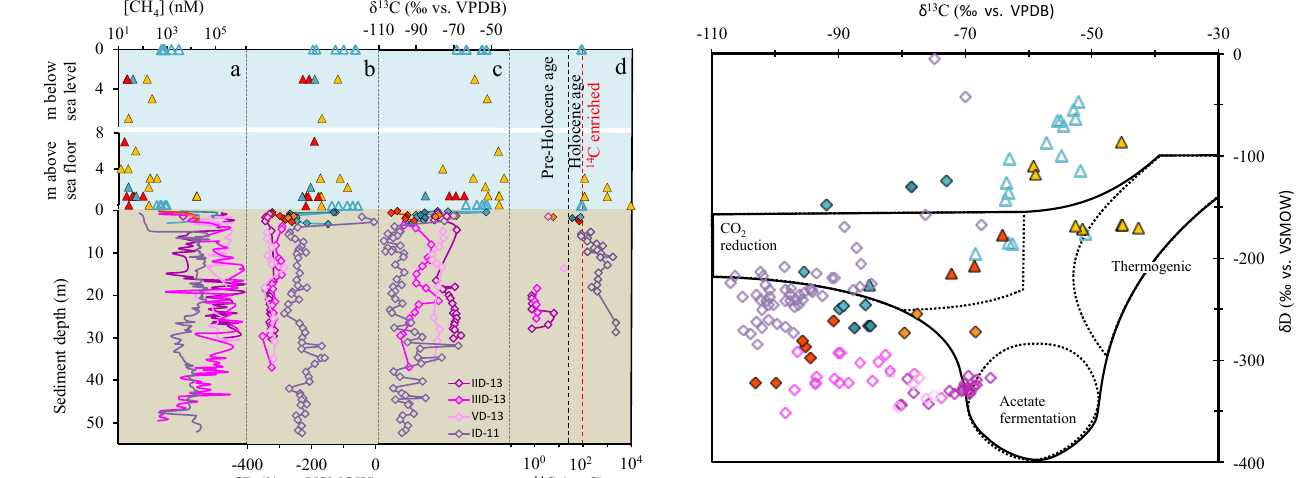
Figure 2. CH 4 data from sediment and overlying water sampled on the East Siberian Arctic Shelf. Water sampling (triangles), sedi- ment cores (diamonds). Summer sampling (close symbols) and win- ter sampling (open symbols). Buor-Khaya Bay (purple, ID-11: non- ebullition site and IID-13, IIID-13 and VD13 hotspot sites), Dmitry Laptev Strait (red and orange), Lena Delta (light blue) and Shelf Edge (yellow) (see Fig. 1 for detailed location). (a) CH 4 concen- trations, (b) δ D (‰ versus VSMOW), (c) δ 13 C (‰ versus VPDB), (d) 14 C (pmC). The red dotted line corresponds to modern values (i.e., 100pmC) and the black dashed line corresponds to the onset of the Holocene (11000 years BP). Note that the y axis for the wa- ter samples is divided in two sections. The upper part corresponds to the depth from the sea surface and the lower part corresponds to the depth from the seabed. See Figs. S1–S4 for the ice-bonded permafrost table depths and Table S1 for bathymetric information.